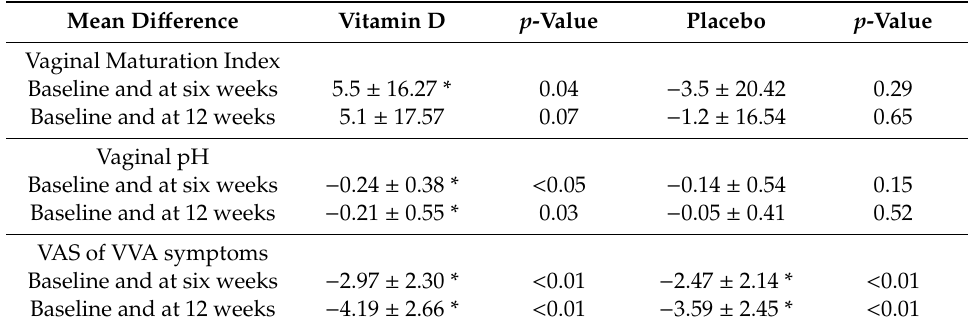
Table 3. Comparison of the mean di ff erence of vaginal health measurement between the vitamin D group and placebo group compared between the baseline and at six weeks and between the baseline and at 12